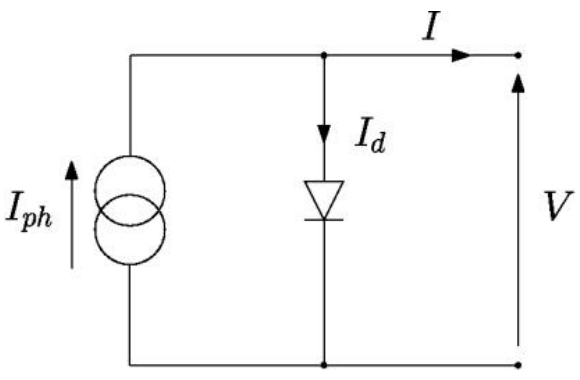
Figure 1. Equivalent circuit of an ideal solar PV cell.